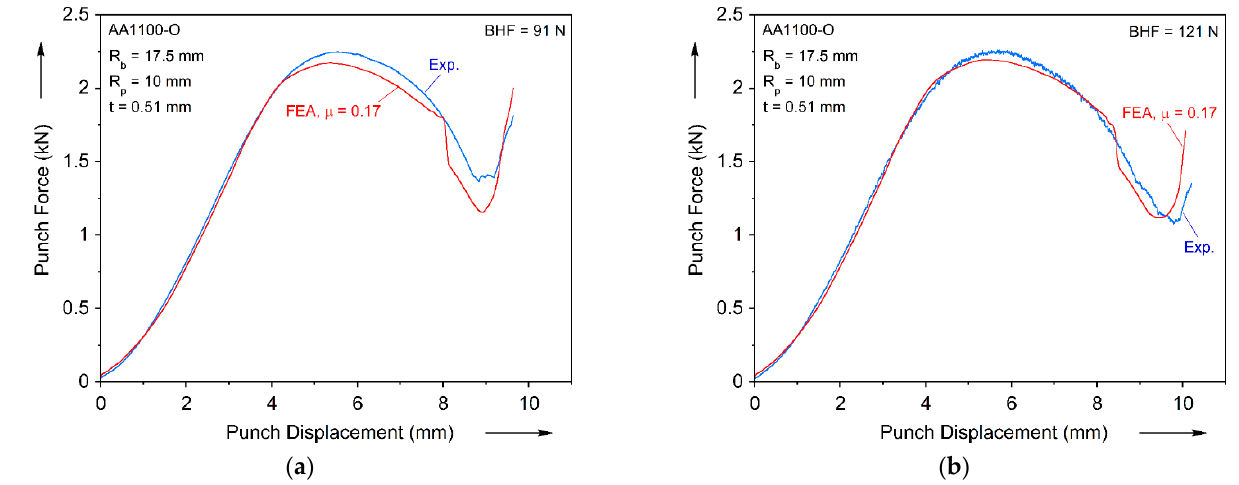
Figure 12. Comparison of the predicted and measured punch-force displacement curves: ( a ) 91 N BHF case; ( b ) 121 N BHF